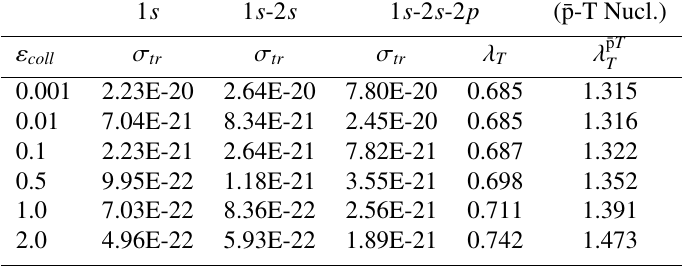
Table 1. Total ¯pD-atom formation cross sections σ tr ( ε coll ) and rates λ D in the three-body reaction (2), where α = 1 s and ε coll is the collision energy (eV). The rate is a product of the formation cross sections and the corresponding center-of-mass velocities v cm between ¯p and D µ in the input channel. The results are represented in the framework of di ff erent close-coupling approximation models, Eq. (6). The cross section σ tr is given in cm 2 and λ D in m.a.u. Results with inclusion of the strong nuclear interaction between ¯p and D are represented only in the six-state model. Our rates λ D are multiplied by factor of 5.